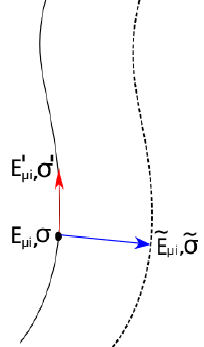
( x ) = (cid:22)i ( x ) is space dependent SO(3) i